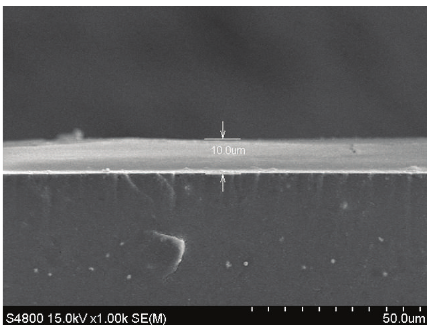
Figure 7: Cross-sectional FE-SEM image of photoelectrode thin film.